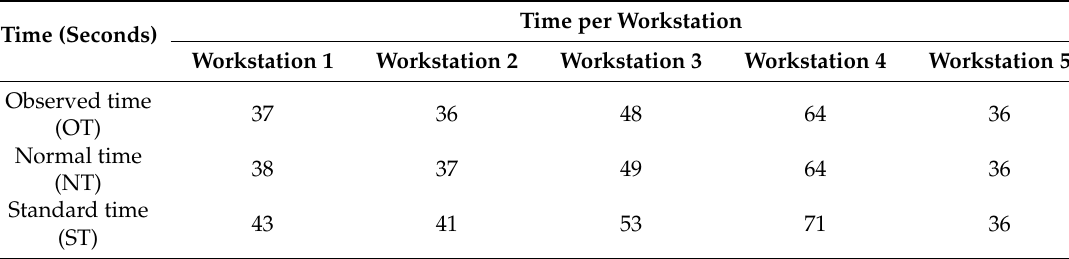
Table 3. Time estimated in original